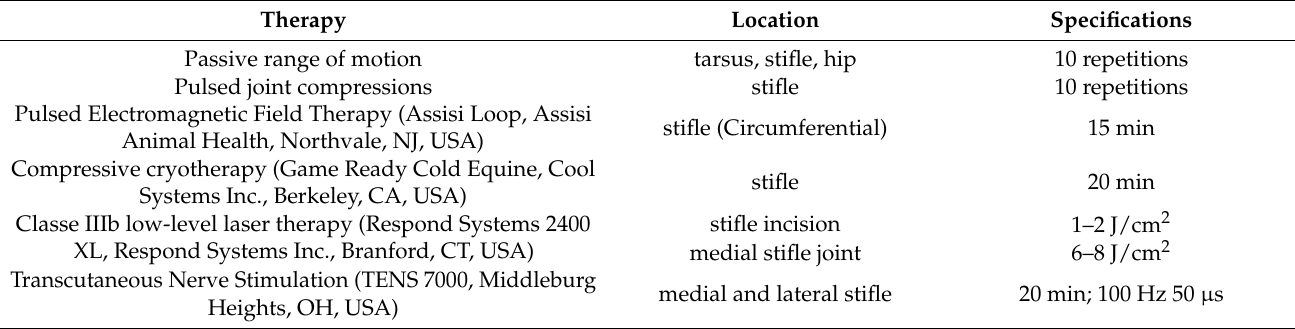
Table 1. Rehabilitation therapies provided to both groups to the surgical